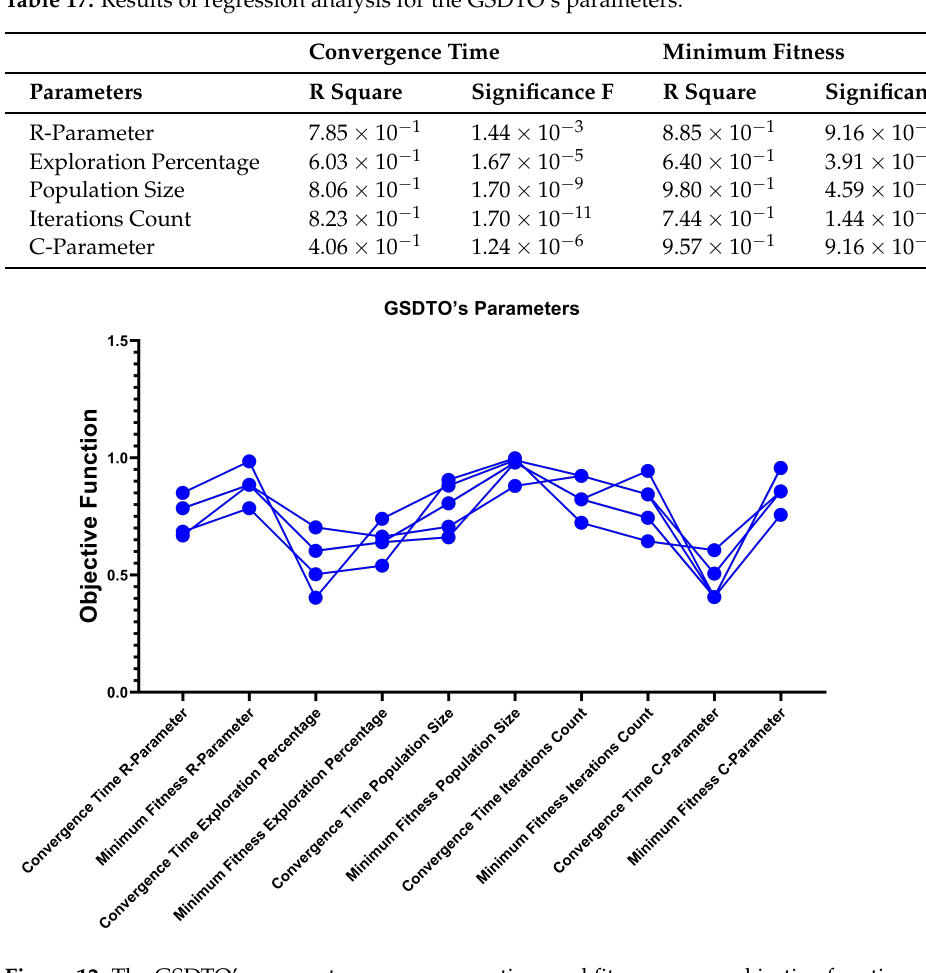
Figure 12. The GSDTO’s parameters convergence time and fitness versus objective